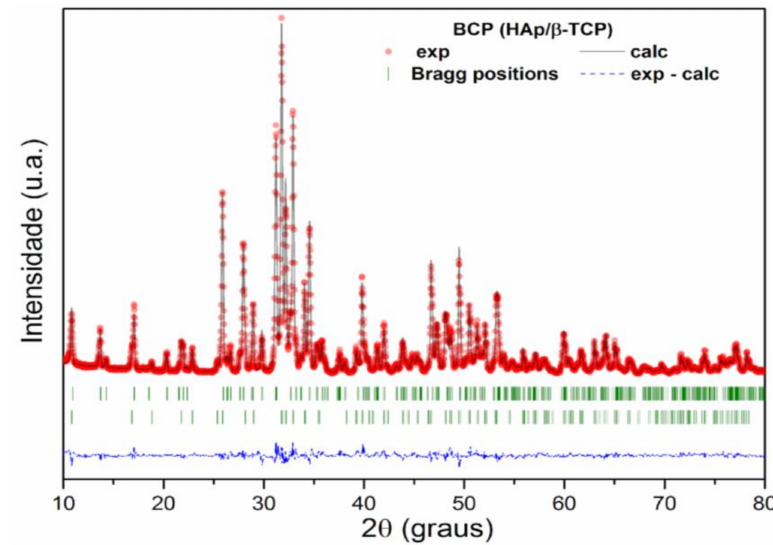
Figure 3. Rietveld refinement results for the calcined and milled BCP powder. The red cir- cles are the experimental XRD data and the black solid line is the refinement result (calculated value). The calculated Bragg positions correspond to the short vertical lines (green), while the bot- tom trace represents the graph of the difference between the experimental and calculated profile.